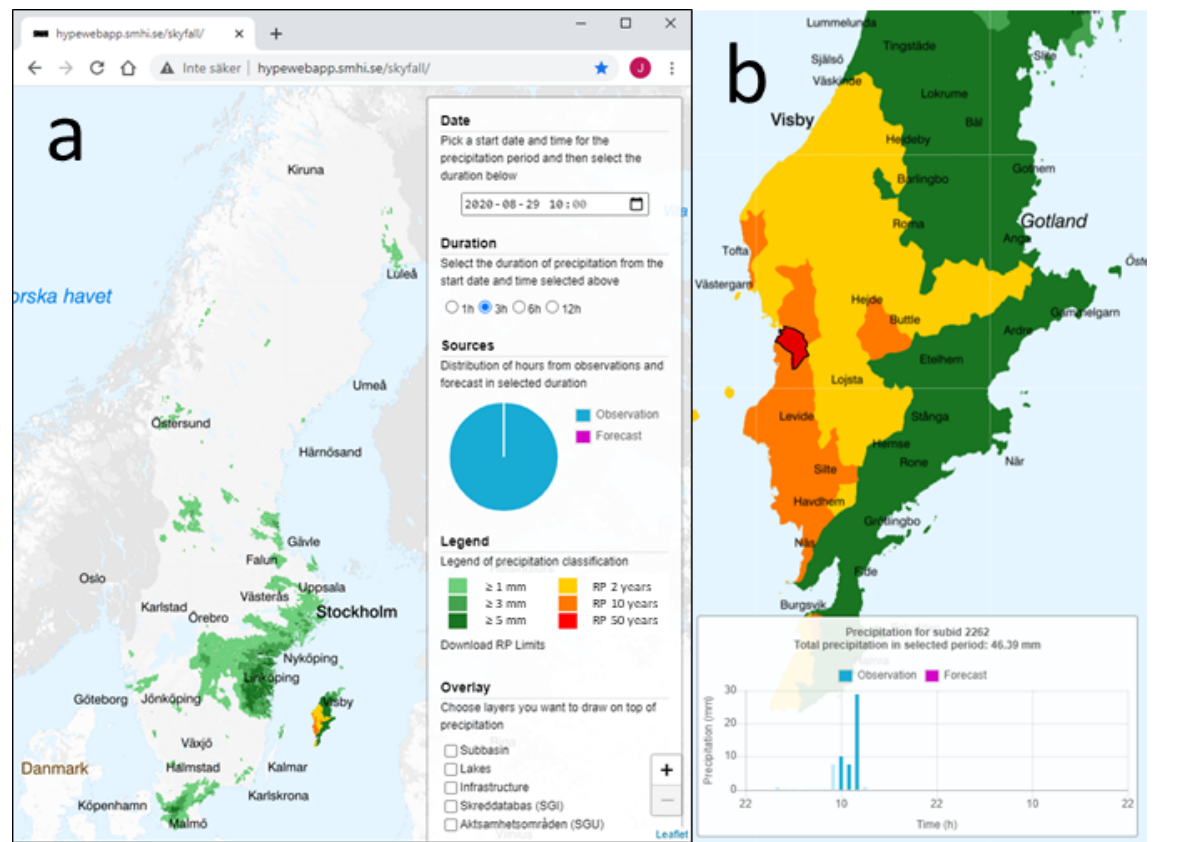
Figure 1. Rainfall over Sweden (a) and central Gotland (b) between 10:00 and 13:00CET on 29 August 2020 as seen in the visualization